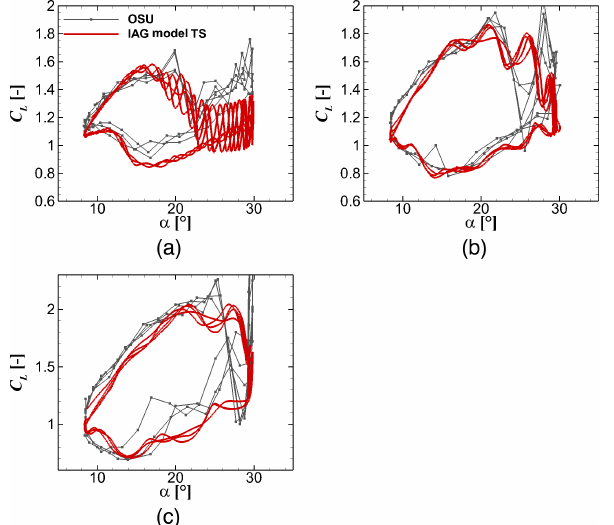
Figure 15. Lift reconstruction by the IAG model in comparison with the measurement data (Ramsay et al., 1996) for (cid:49)t = T/ 1440 using the actual angle of attack in the experimental campaign at various k values. From (a) to (c) : k = 0 . 036, k = 0 . 073 and k